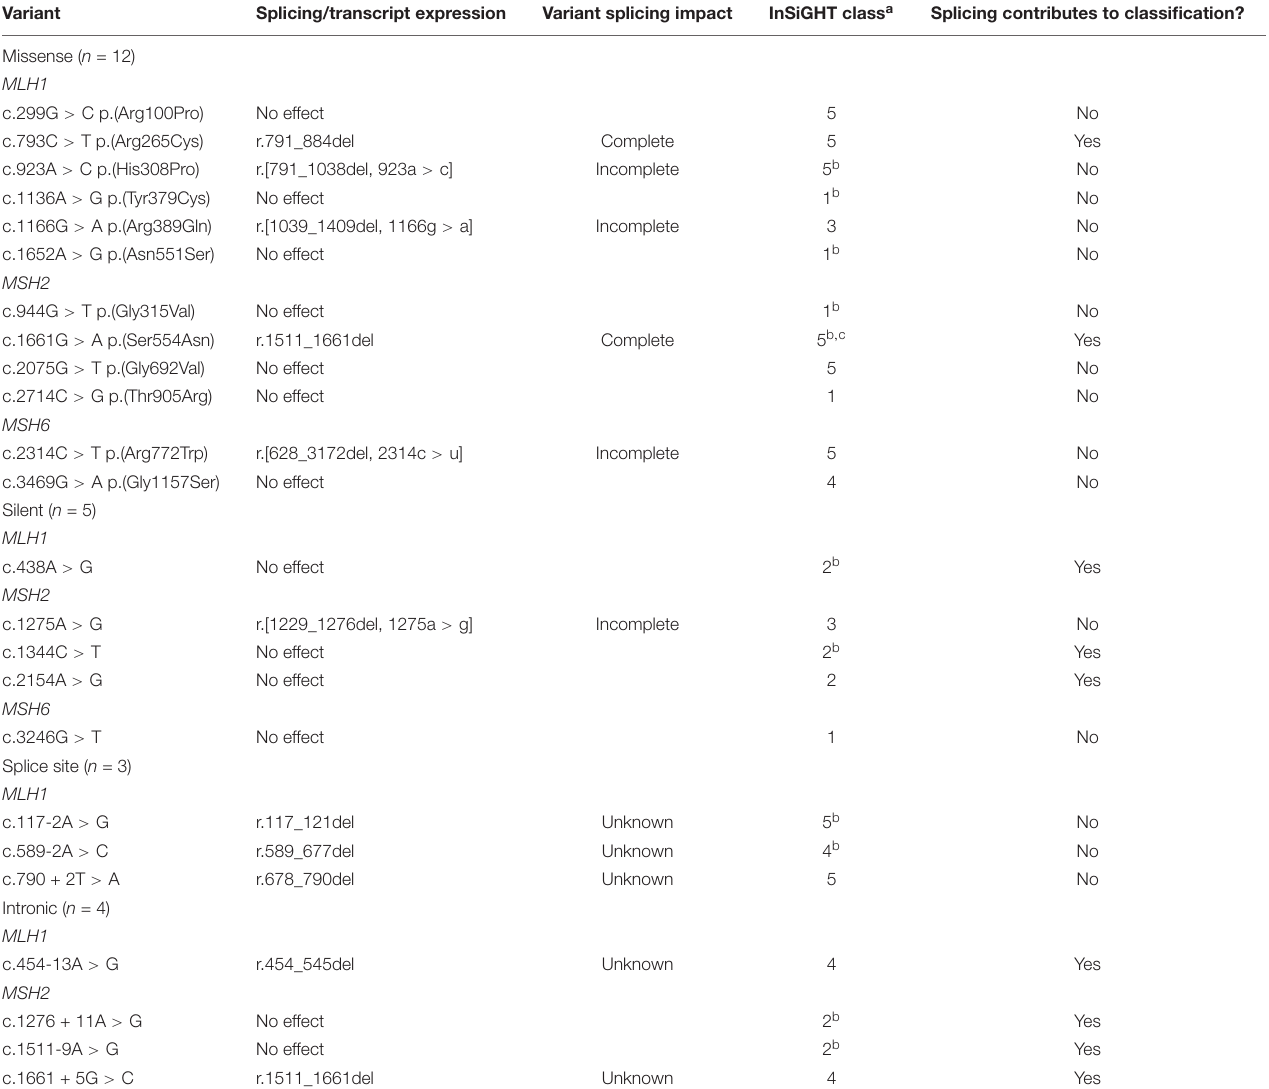
TABLE 1 | Summary of splicing assay results from this study and their contribution to variant